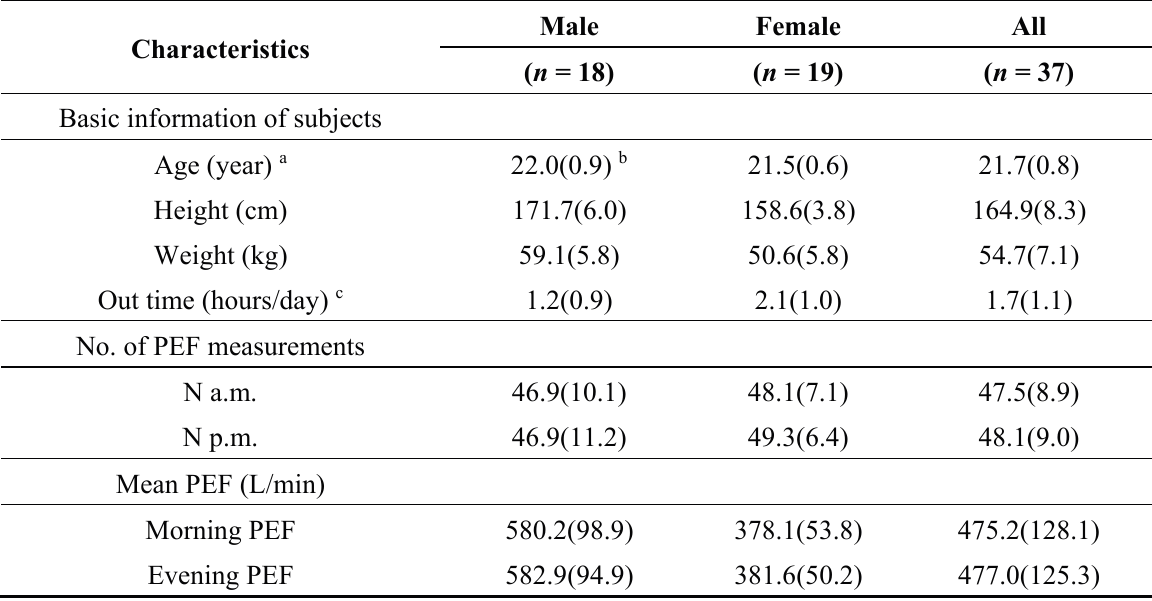
Figure 1. Daily indoor/outdoor PM 2.5 concentration and average temperature during study period. In PM2.5, daily average concentration of indoor PM 2.5 ; Out PM25, daily average concentration of outdoor PM 2.5 ; NAAQS, National Ambient Air Quality Standard for PM 2.5 in U.S.; WHO, World Health Organization air quality guideline for PM 2.5 ; PM 2.5 , particulate matter <2.5 µm in aerodynamic diameter. Table 1. Basic characteristics and PEF measures of the study